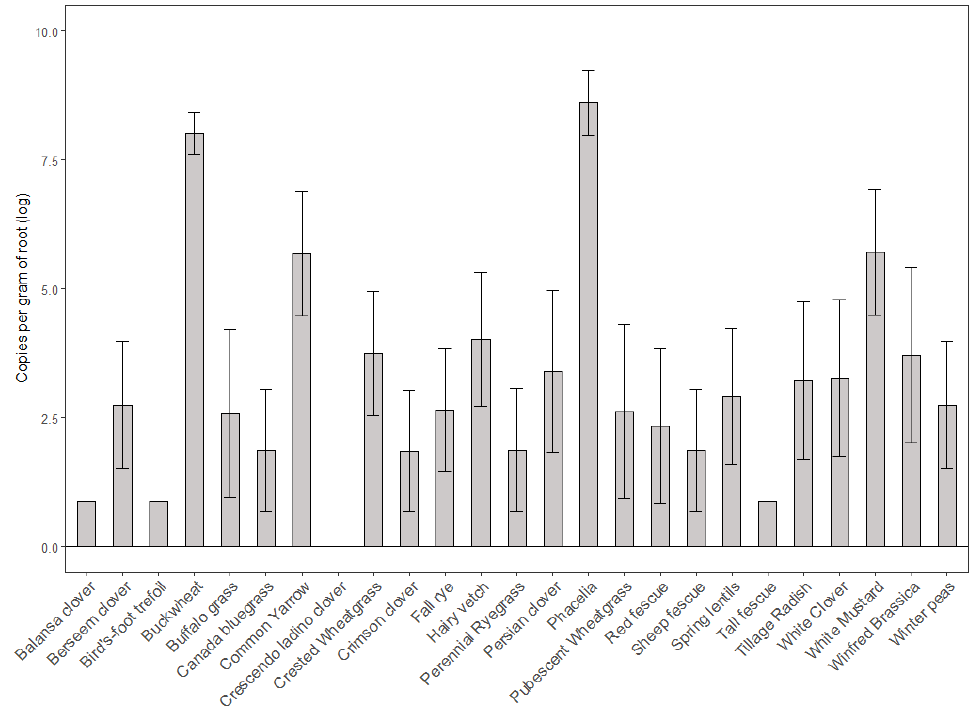
Figure 1. Log concentration of Ilyonectria DNA (copy number per gram of root) isolated from surface sterilized cover crop roots grown for three months. Log-transformed data are displayed. Dotted line represents the amount of inoculum added to each pot, for comparison.